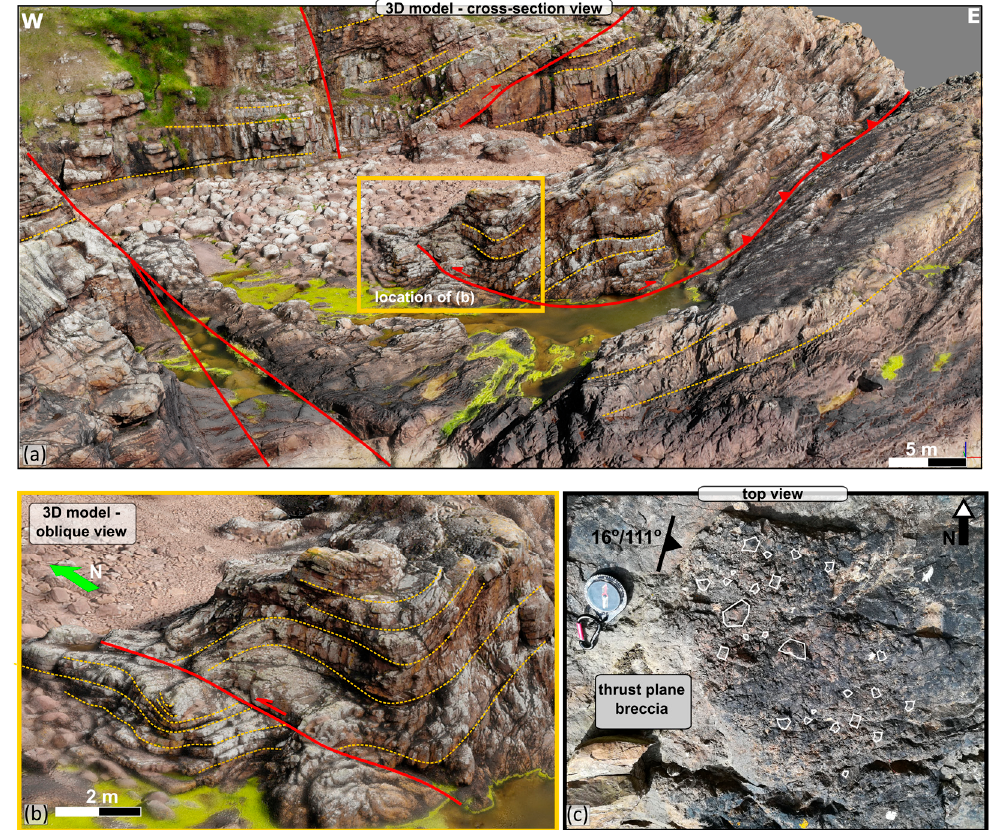
Figure 6. ( a ) Three-dimensional digital outcrop model of the Muiri Geo outcrop (see location on Figure 4b) showing ( b ) fold and thrusted structures. ( c ) Field photograph showing the low-angle thrust plane associated with non-mineralised fault breccia.